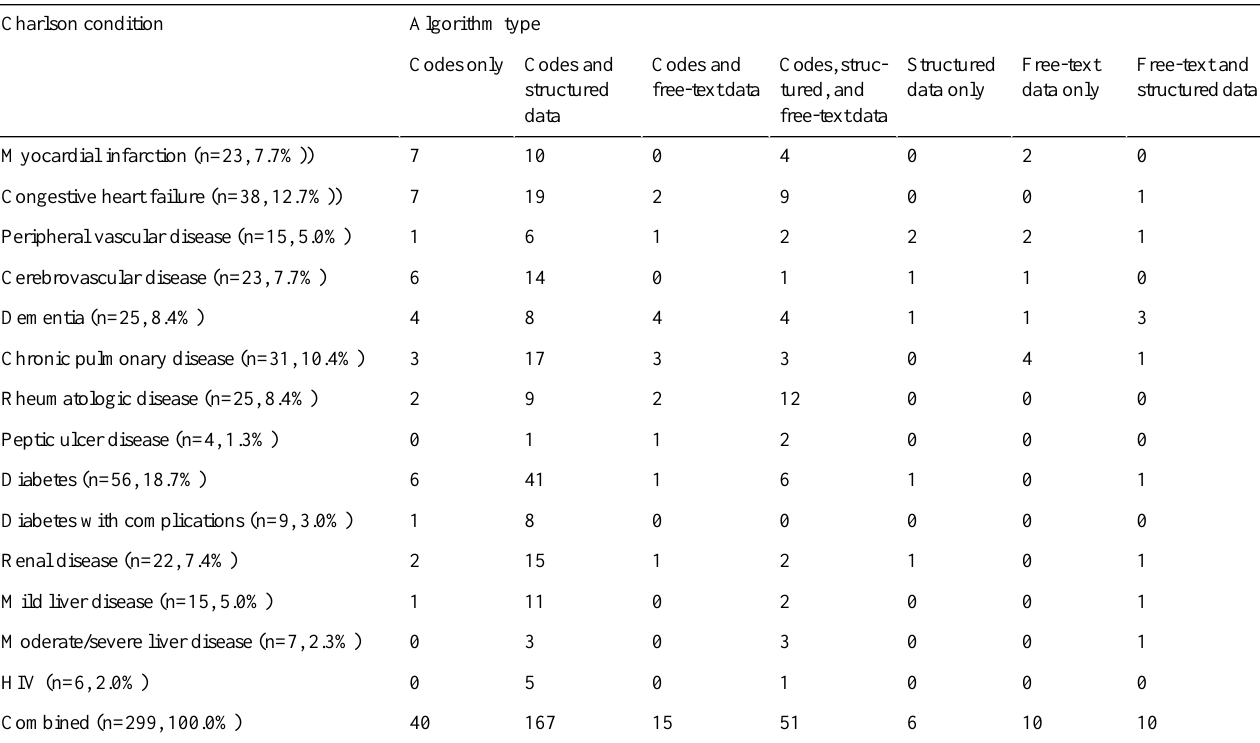
Table 2. The Charlson algorithm types identified in this scoping review.